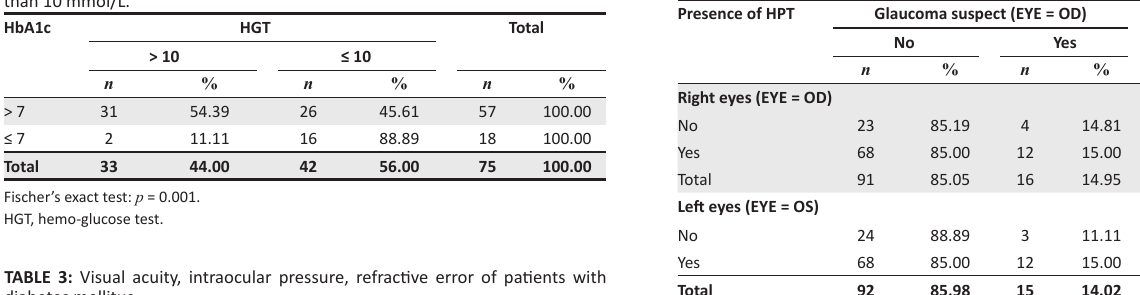
TABLE 3: Visual acuity, intraocular pressure, refractive error of patients with diabetes mellitus. Categories